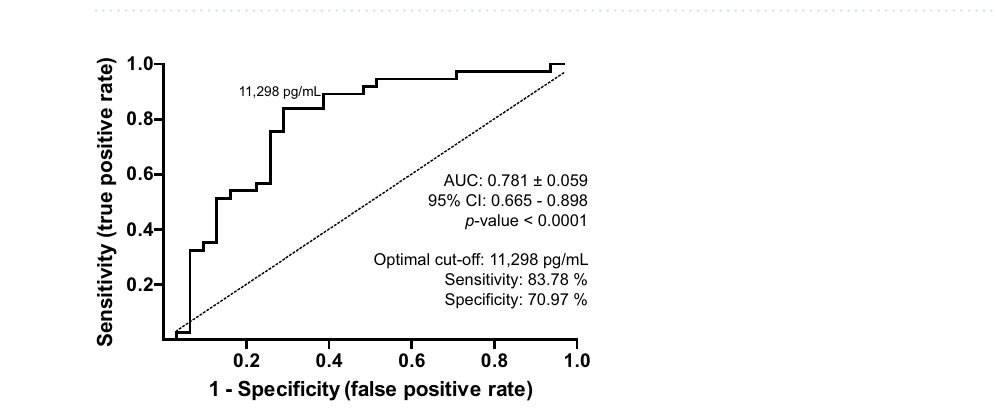
Figure 3. Serum IGFBP-1 ( A ) and ErbB2 ( B ) levels in patients undergoing aseptic hip revision (AL) and primary THA (PR). Results are presented as box and whisker plots in which the centerlines show the median, boxes represent the range between the first and third quartile and whiskers illustrate the highest and lowest value. * p < 0.05.